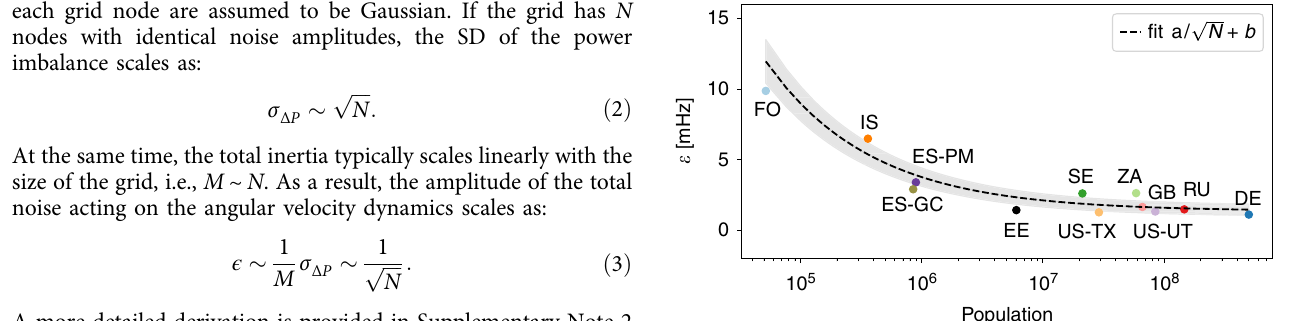
Fig. 2 Heterogeneity in power-grid statistics. Both histograms and autocorrelation functions display very distinct features between the different synchronous areas. a – c Histograms of the different synchronous areas provide insight on heavy tails but also the different scales of the fl uctuations. We visualise the empirical probability distributions of the various areas by histograms on a logarithmic scale. d – f The complex autocorrelation decay reveals distinct timescales in the different grids. We compute the autocorrelation of each area for a time lag of up to 75 min. each grid node are assumed to be Gaussian. If the grid has N